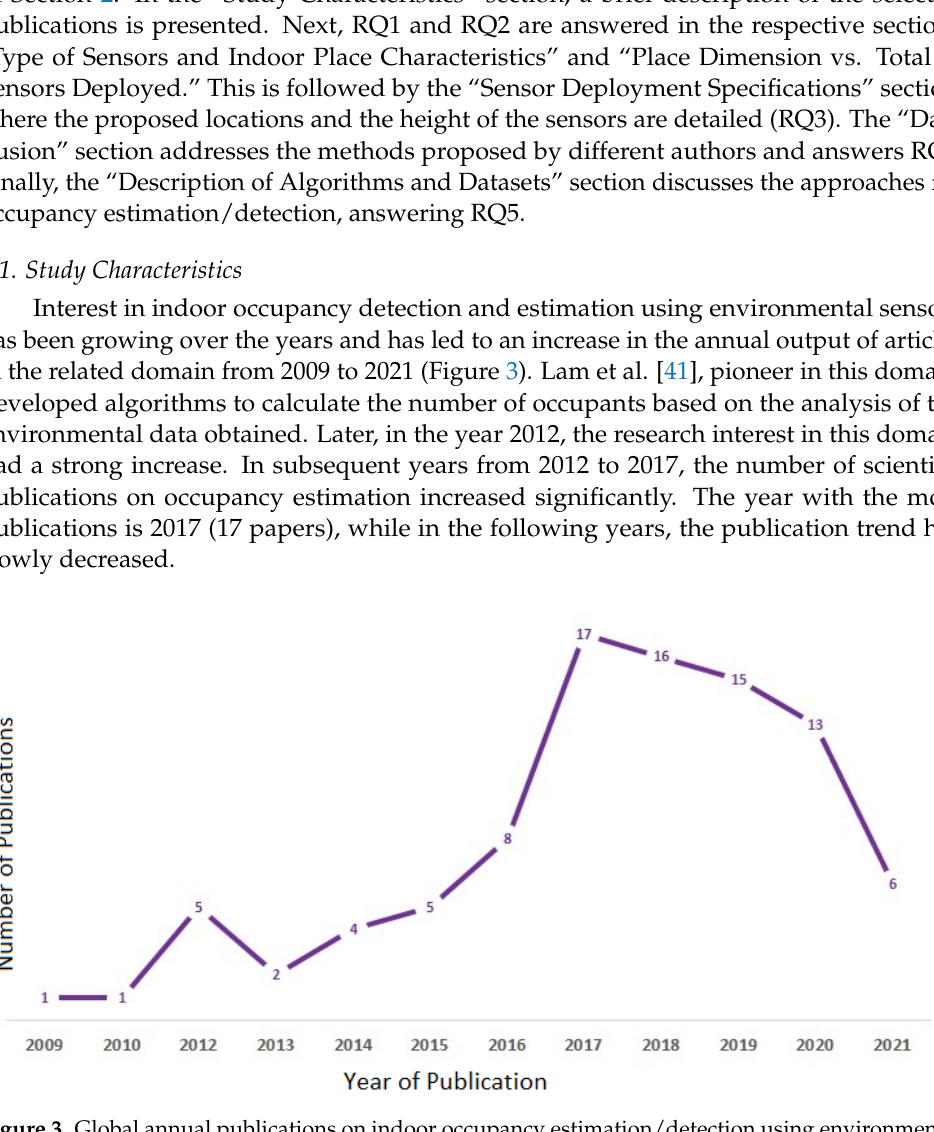
Figure 3. Global annual publications on indoor occupancy estimation/detection using environmental